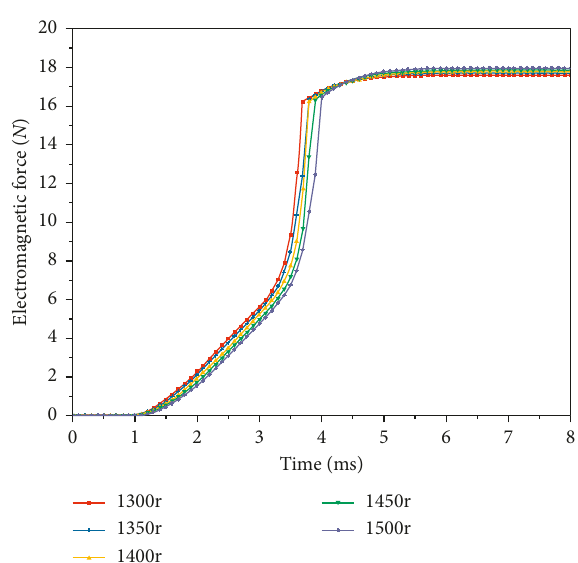
Figure 14: Electromagnetic force under different coil